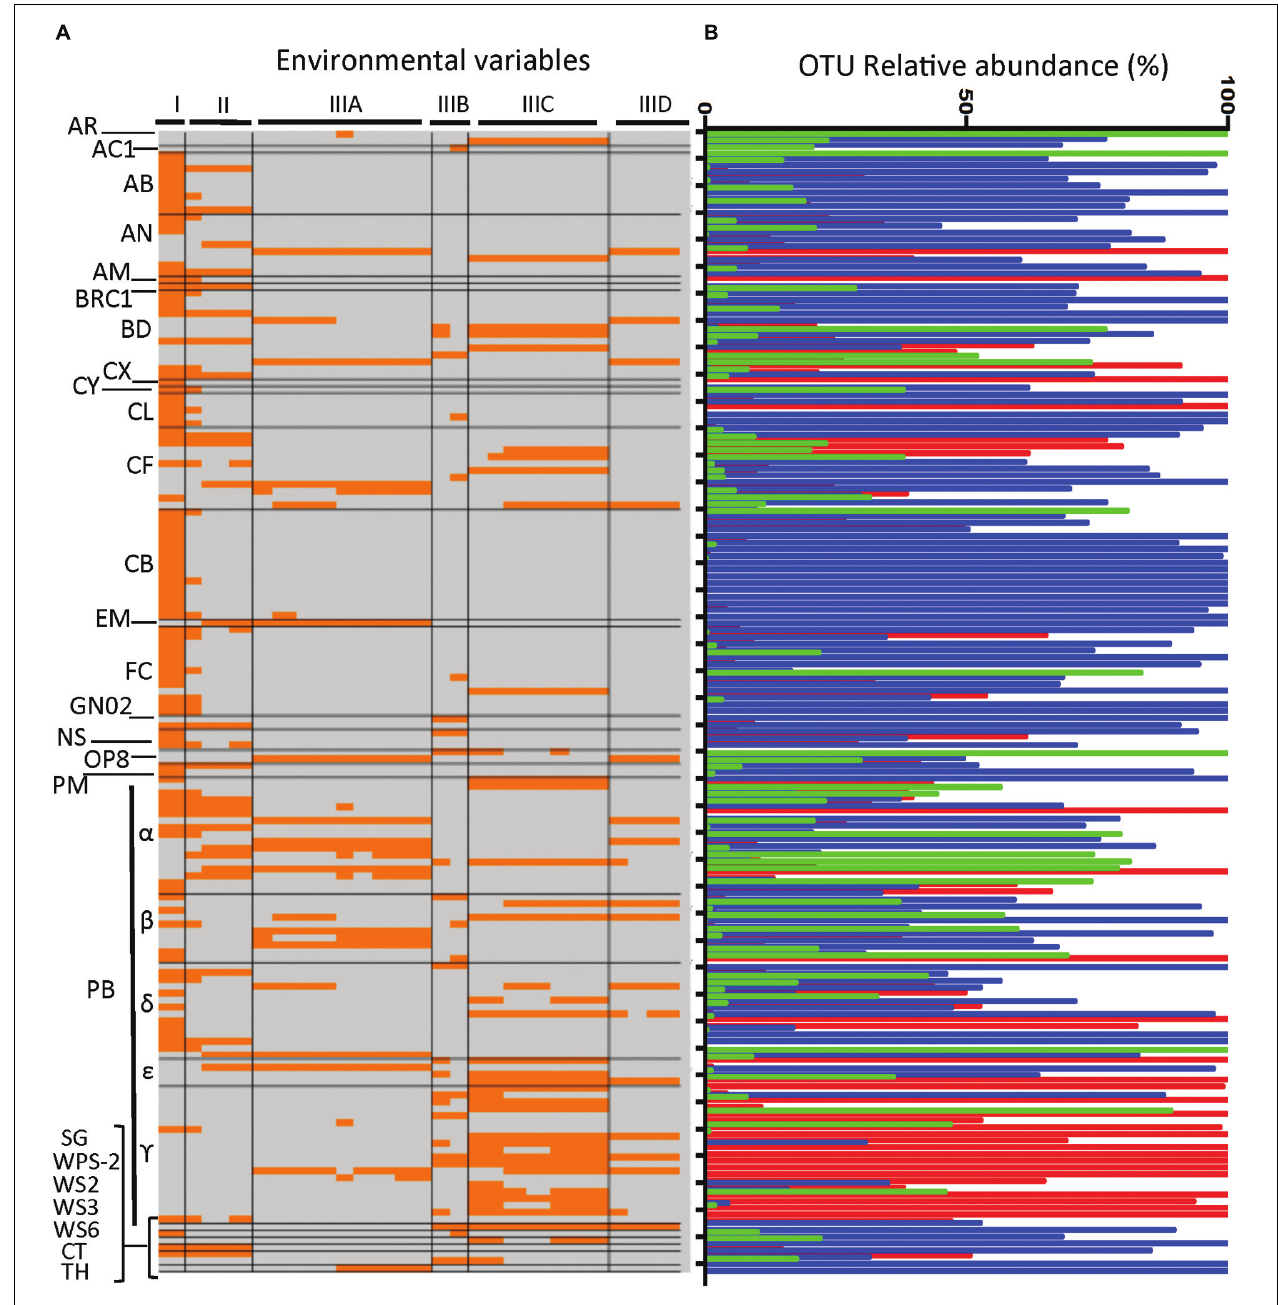
FIGURE 8 | (A) Heat map comparing environmental variables correlated with OTU abundance as a function of OTU taxonomic identity. (B) Comparison of OTUs taxonomic identity with OTU abundance across sites. (A) Environmental factors are given across the top as the groupings determined by CLUSTER analysis (see groupings in dendrogram, Figure 7 ). The OTUs are listed along the left and are grouped alphabetically by taxa. Each line is an OTU, and sections of the line that are colored orange identify environmental variables that were significantly correlated with abundance of the OTU; line sections colored gray correspond to variables that were not significantly correlated with OTU abundance. Taxa identifications are abbreviated as: AR, Archaea; AB, Acidobacteria; AC1, candidate phylum, AN, Actinobacteria; AM, Armatimonadetes; BD, Bacteroidetes; CX, Calithrix; CY, Chlamydiae ; CB, Cyanonbacteria; CF, Chloroflexi; EM, Elusimicrobia; FC, Firmicutes; GN02, candidate phylum; NS, Nitrospira; OP8, candidate phylum; PM, Planktomycetes; PB, Protoebacteria; CL, Chlorobi; BRC1, candidate phylum; SG, Synergistetes; WPS-2, WS2, candidate phylum; WS3, candidate phylum; WS6, candidate phylum; CT, Caldithrix; TH, Thermi. Greek letters denote proteobacterial classes: α , alpha; β , beta; γ , gamma; δ , delta, and ε , epsilon. (B) Relative abundance of each OTU (each line from A ) in each of the sediments is indicated by the bars in (B) , which are colored by site: Apapa, red; Ofin, blue; Eledu, green. Abundance of a given OTU at each site is expressed as a percentage of the total number of quality-filtered amplicons assigned to that OTU across all